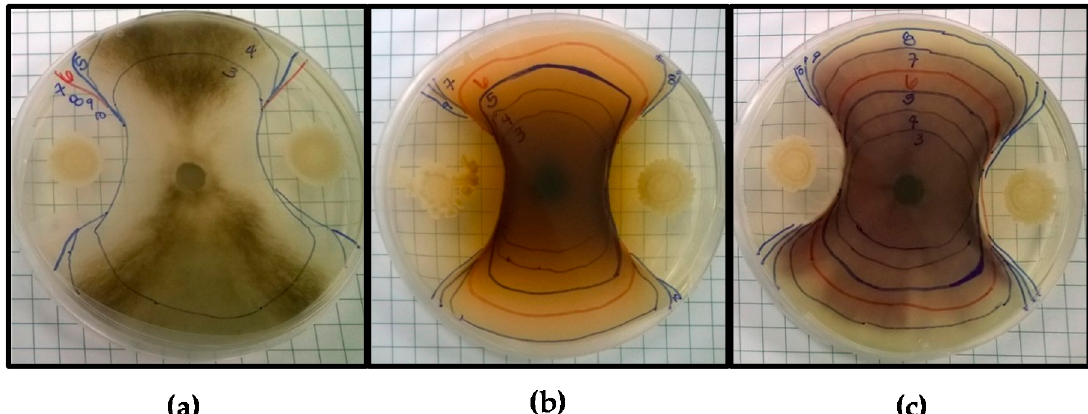
Figure 1. Antifungal screening of Bacillus amyloliquefaciens BA4 against ( a ) Botrytis cinerea ; ( b ) Fusarium pallidoroseum , and ( c ) Fusarium moniliforme . Markings indicate the border of the fungal colony each day of incubation, beginning on Day 3 up until Day 10 or the last day of observed